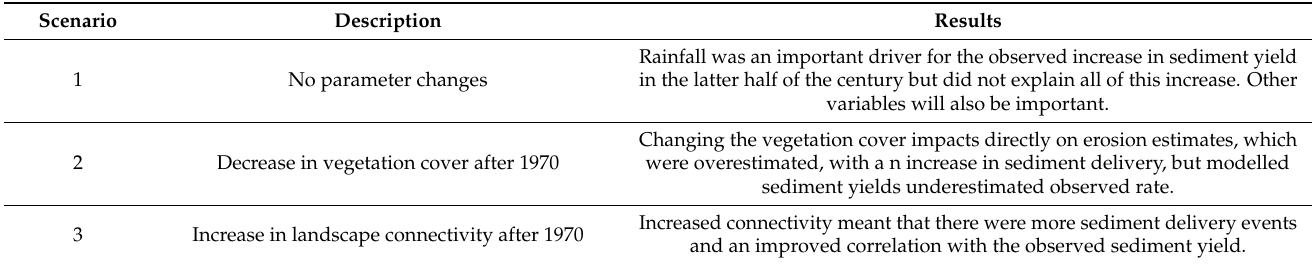
Table 2. Scenarios for model